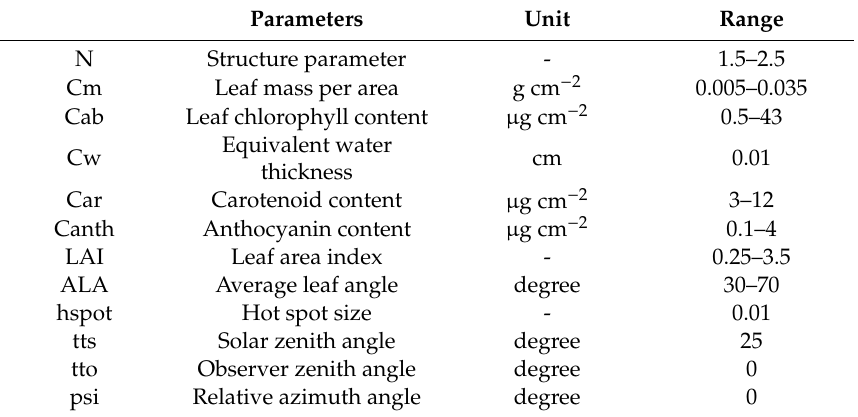
Table 2. Input parameters and ranges of PROSAIL used for generating the